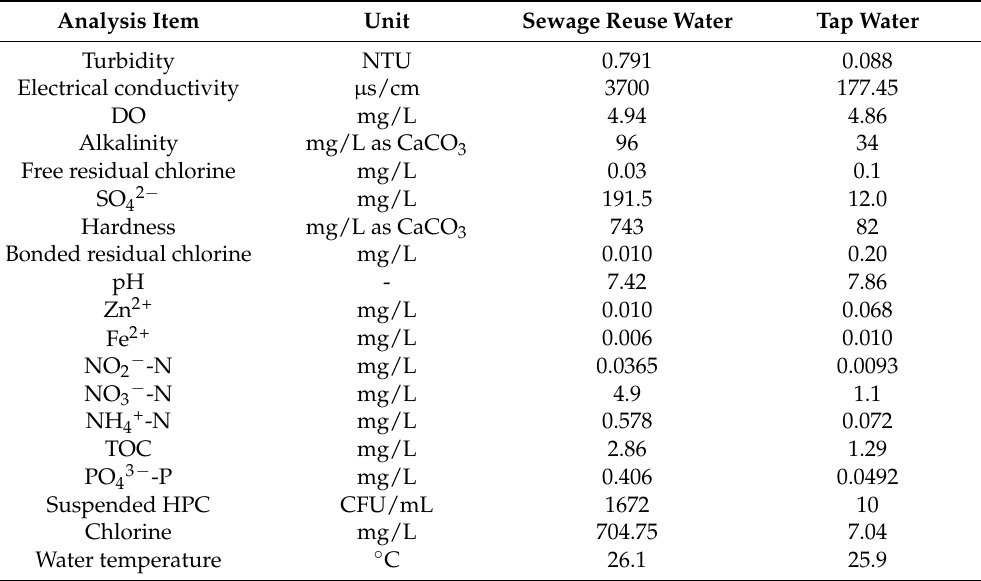
Table 5. Characteristic properties of adjusted RW and